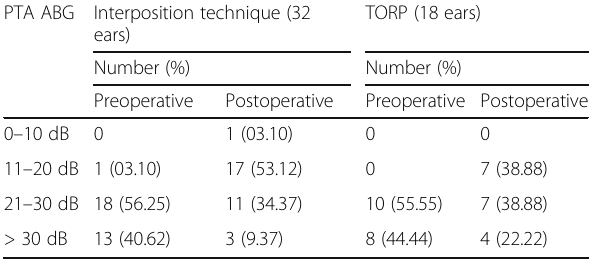
Table 1 Preoperative and postoperative ABG in 10 dB interval PTA ABG Interposition technique (32